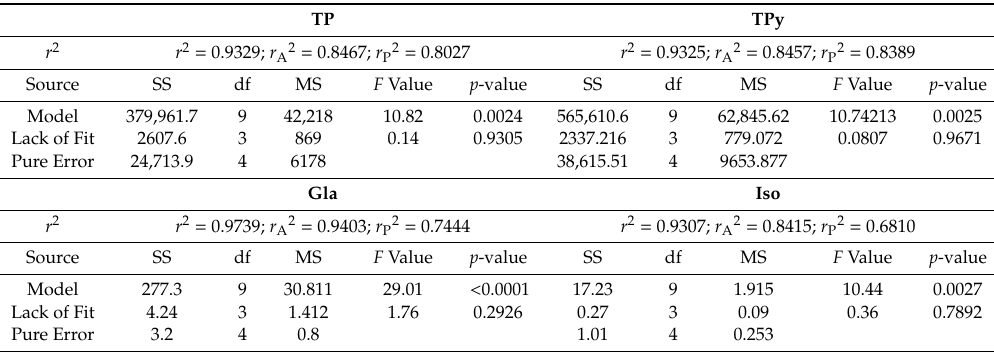
Table 4. Analysis of variance (ANOVA) for the fitted quadratic models for optimization of G. glabra extraction process.